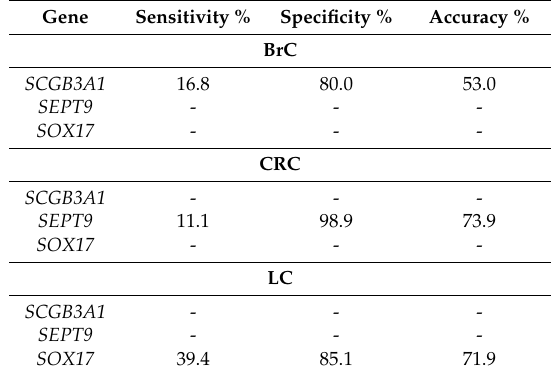
Table 4. Performance of gene promoter combinations for discrimination among BrC, CRC and LC.